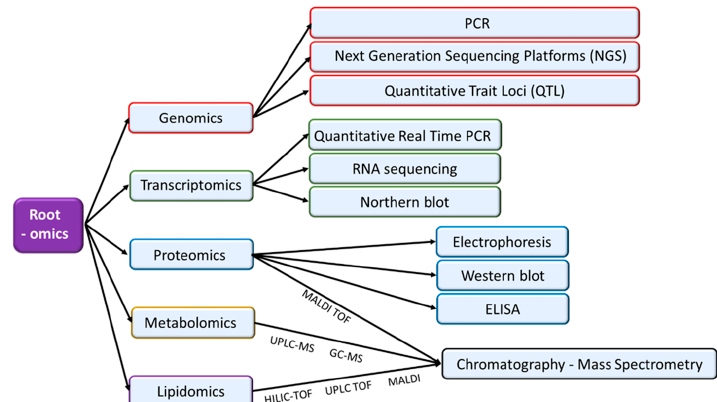
Figure 2. Omic- approaches, including genomics, transcriptomics, proteomics, metabolomics and lipidomics, make possible active analyses of regulatory networks that control plant organ responses to adverse environmental conditions. In the figure, the most relevant analytical techniques used in each -omic approach are indicated.